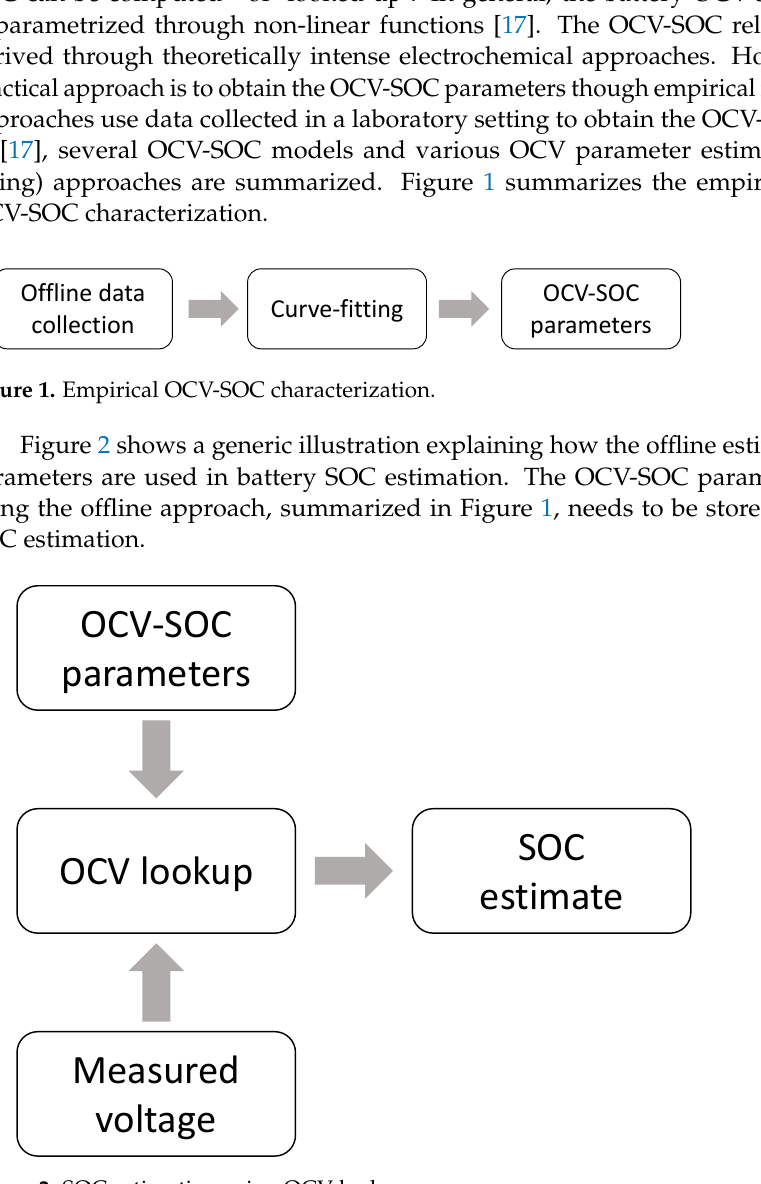
Figure 2. SOC estimation using OCV